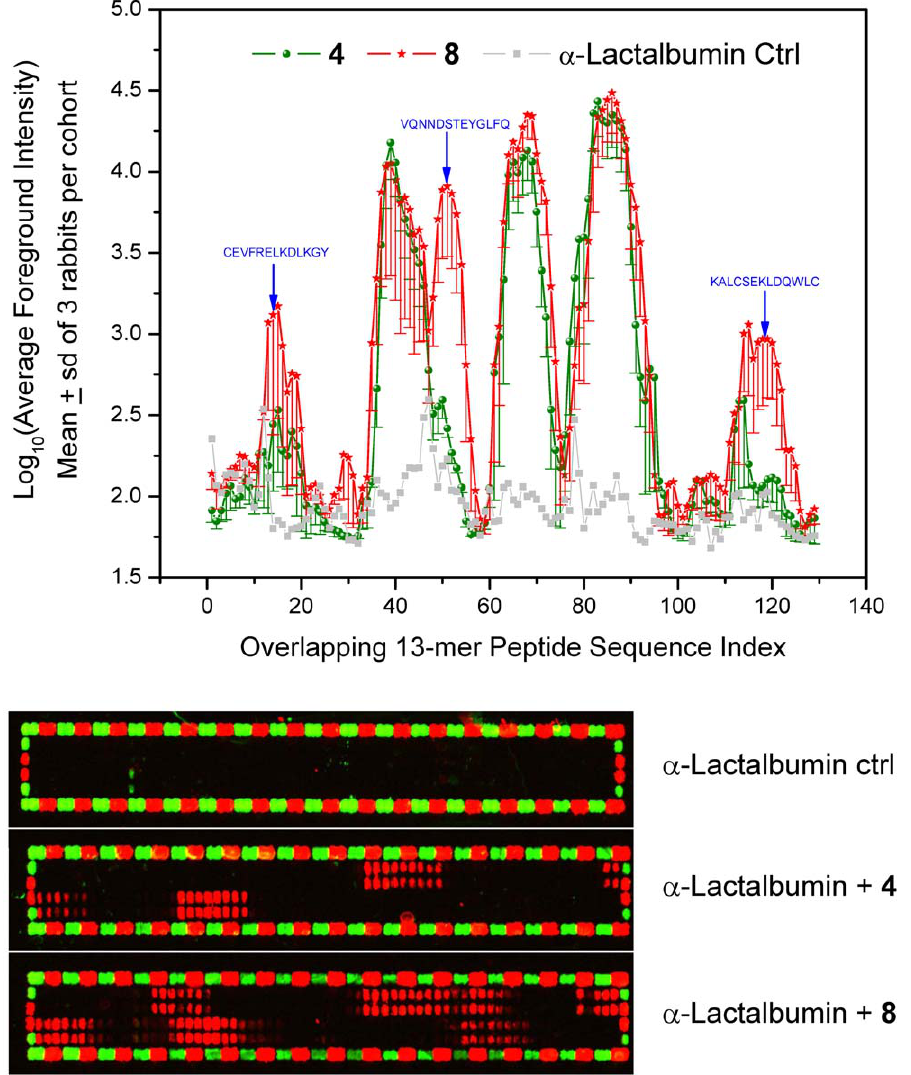
Figure 6. Linear peptide epitope mapping results of immune sera. Top: Foreground fluoresence intensities of secondary goat anti-rabbit IgG (H + L) conjugated with DyLight680 antibody to each overlapping 13-mer peptide in the microarray are shown (means and SD). Bottom: Raw fluorescence images of representative peptide microarrays are shown. Each array is framed by a fusion tag (Flag) peptide (DYKDDDDKGG, 72 red spots) and influenza virus hemagglutinin (HA) epitope tag peptide (YPYDVPDYAG, 72 green spots) which were used as internal controls.